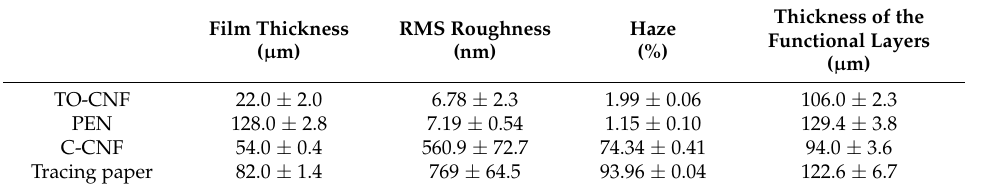
Figure 2. Atomic force microscope (AFM) images of ( a ) TO-CNF, ( b ) PEN, ( c ) C-CNF, and ( d ) tracing paper substrates for the calculation of RMS roughness. Table 1. The characteristics of each film and the thickness of the functional layer on those